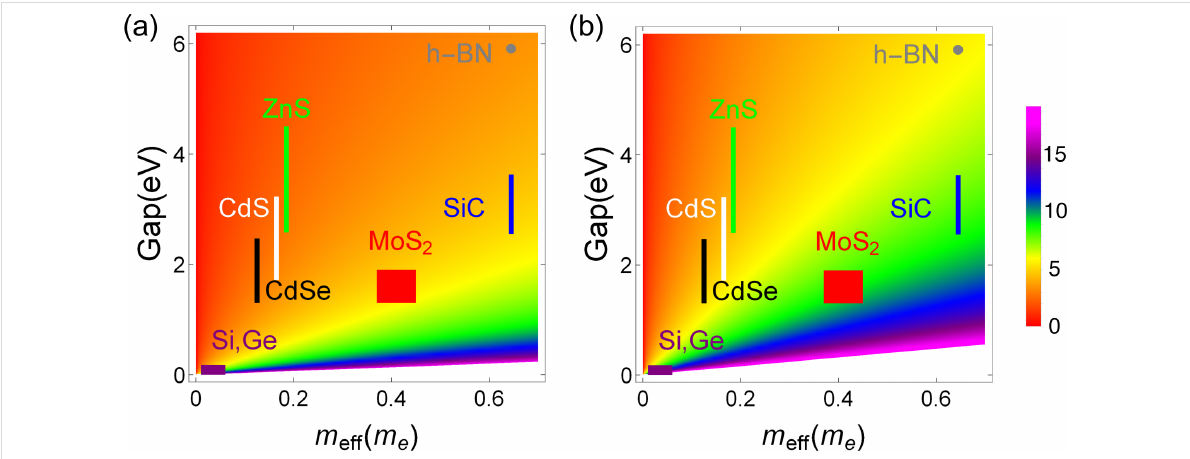
Figure 3: Minimum dielectric constant that guarantees the existence of bound states and the validity of EMA for isolated dopants (a) and dopant pairs separated by R = 2 a * (b). We expect the known values of ε to be in the yellow–orange–red region of the map, which encloses many of the analysed materials. The range of values for masses and gaps available in the literature and summarised in Table 1 are shown by the extended symbols next to the corresponding material